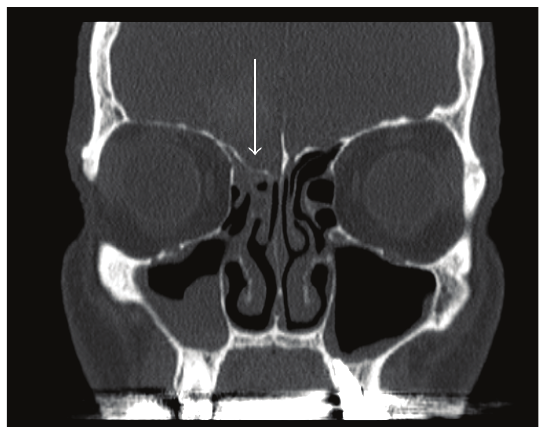
Figure 1: Ethmoid roof is lower on the right side (arrow). Coronary CT scan of a patient with chronic sinusitis.